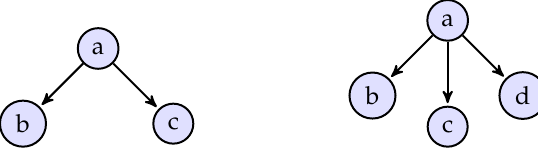
Figure 4. Two simple communication